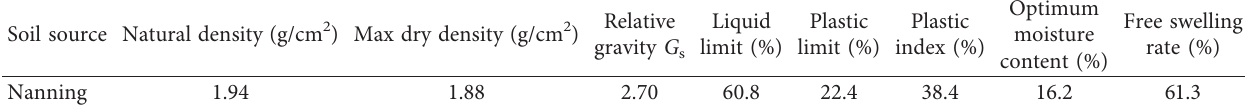
Table 1: Physical properties of the expansive soil.